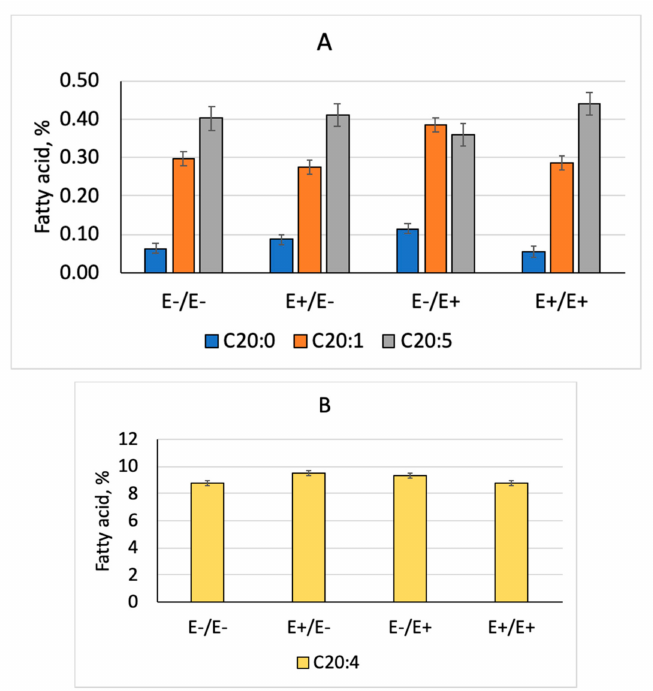
Figure 2. Long-chain 20C fatty acid concentrations in livers of wethers born to ewes consuming endophyte-infected (E + ) or endophyte-free (E − ) fescue during MID (d 35-85) and LATE (d